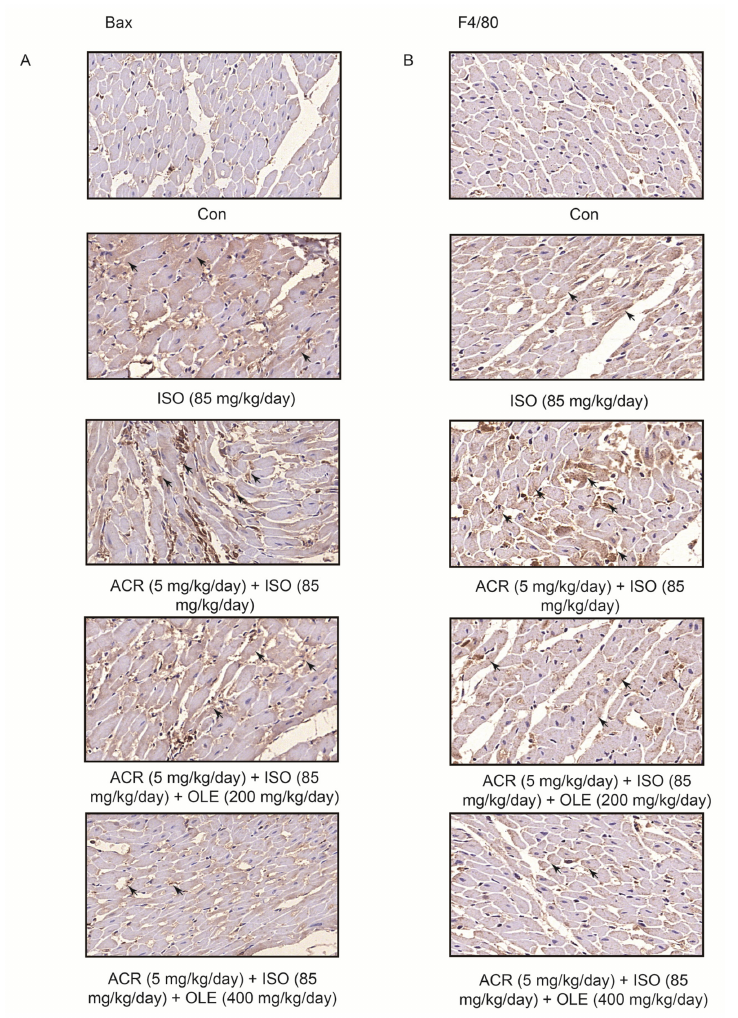
Figure 2. Effect of OLE on myocardial apoptosis and infiltration of macrophages induced by acrolein. ( A , B ) Representative photographs of heart sections with immunohistochemical staining of Bax and F4/80 (400 × ) in different